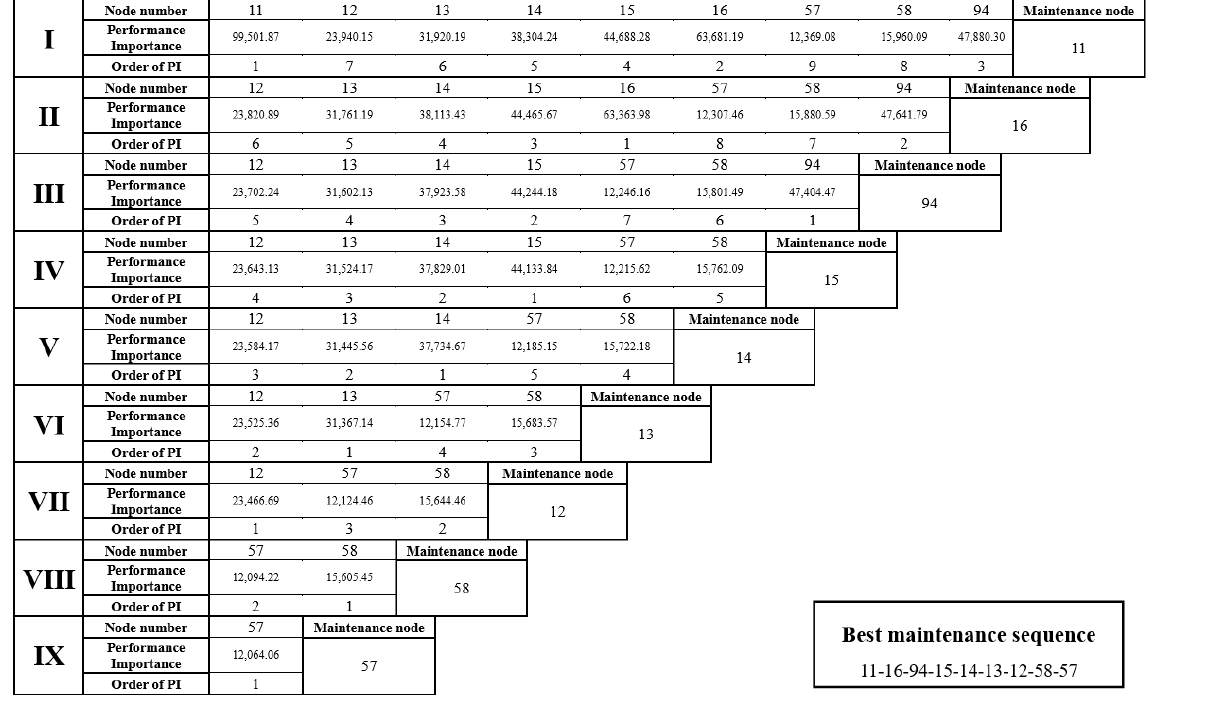
Figure 13. Performance importance and optimal maintenance order.